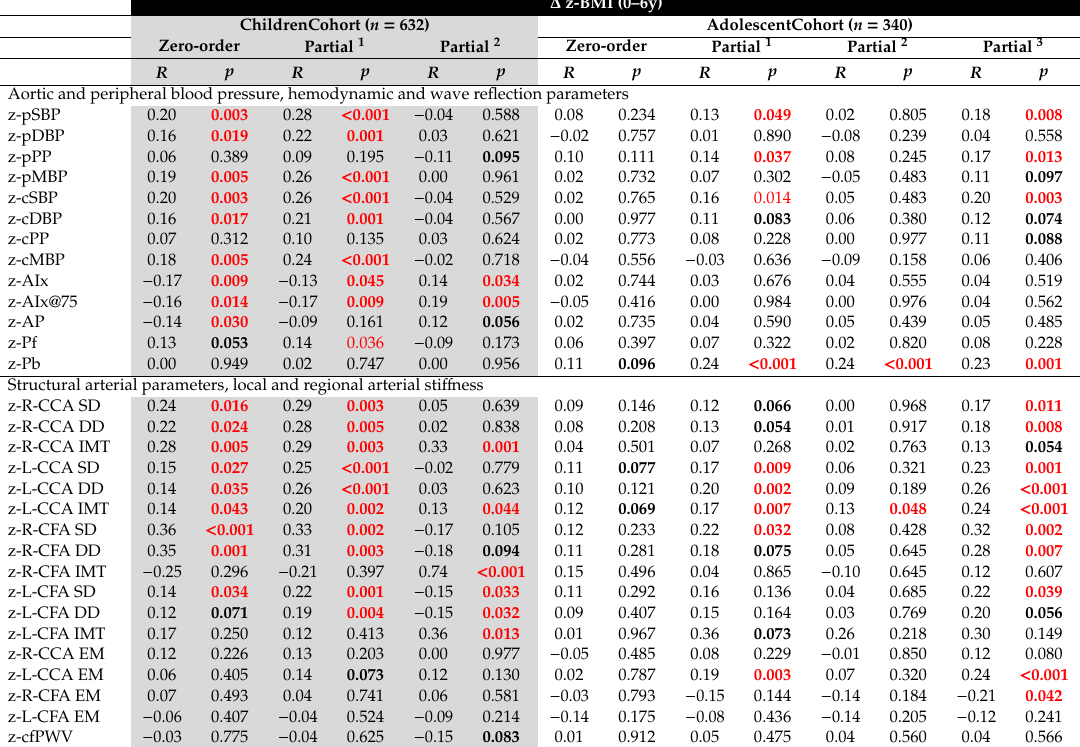
Table 6. Associations between CV z-scores and z-BMIvariations between 0–6 y(both cohorts). ∆ z-BMI (0–6y) ChildrenCohort ( n = 632) AdolescentCohort ( n = 340) Zero-order